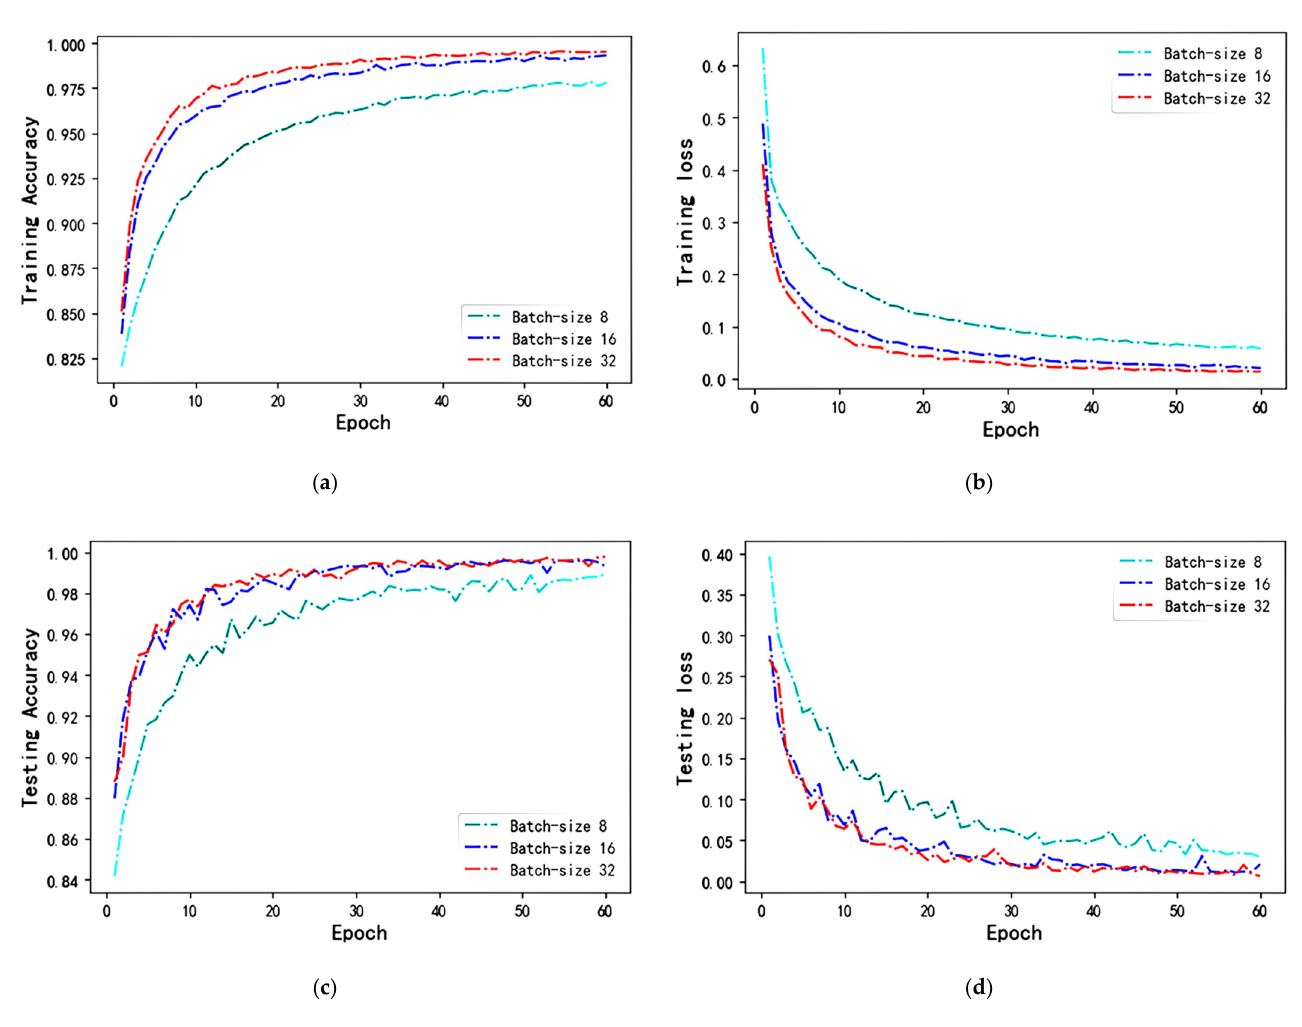
Figure 8. Training and testing accuracy and loss value curves of different batch-sizes. ( a ) Training accuracy; ( b ) Training loss; ( c ) Testing accuracy; ( d ) Testing loss.